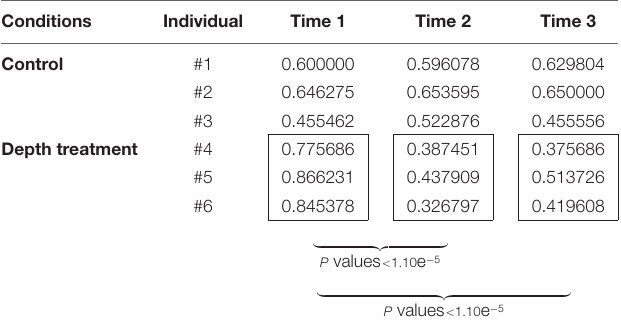
TABLE 1 | Darkness values obtained with the ImaginR R package